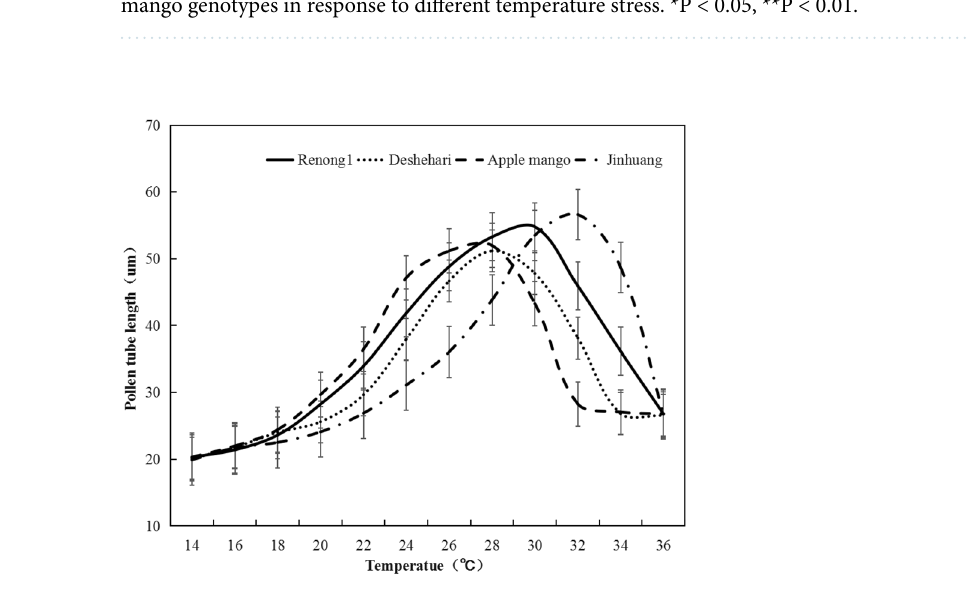
Figure 3. Pollen tube length of four mango genotypes responsed under different temperature stress.